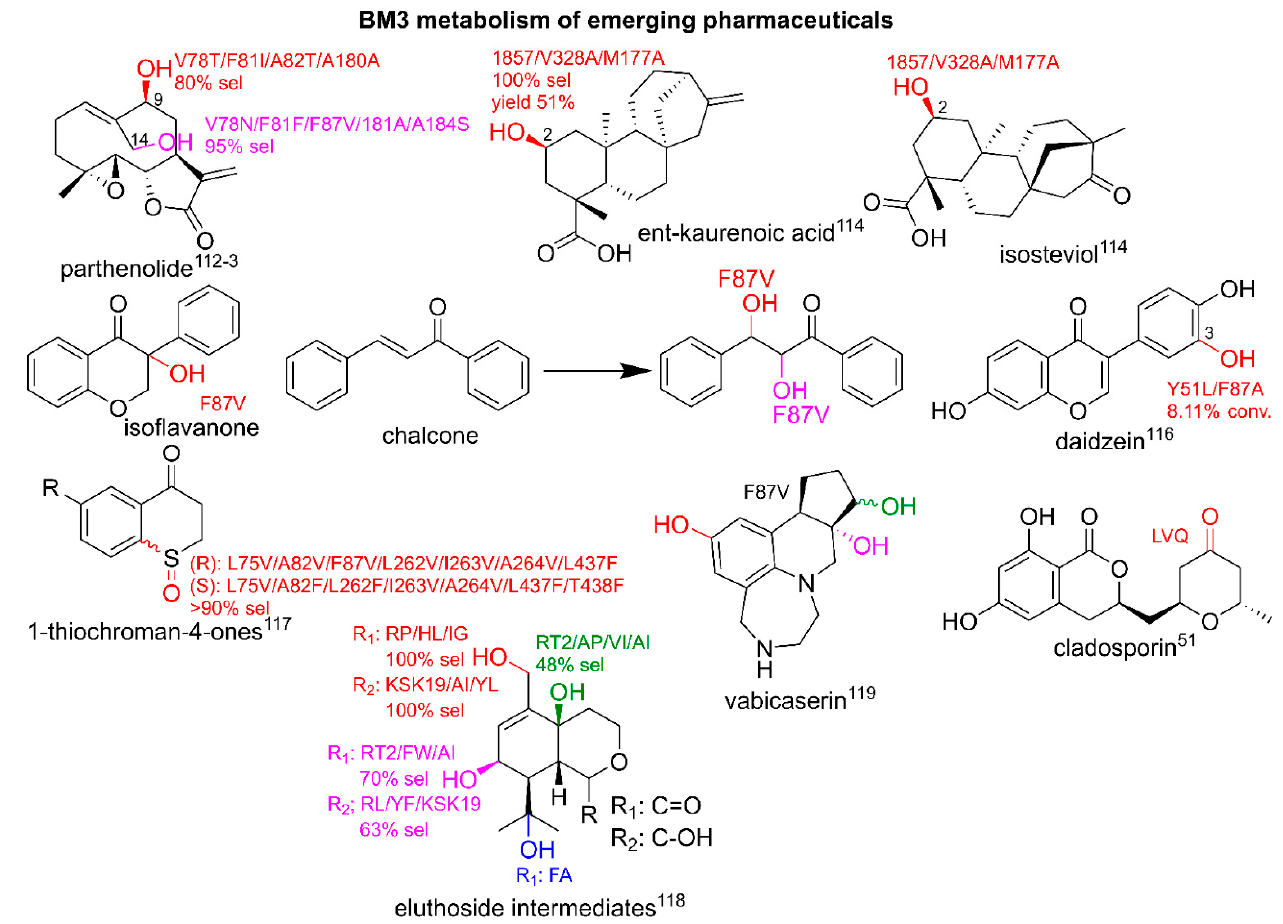
Figure 7. BM3-mediated metabolism of emerging pharmaceuticals. Parent compounds are in black. Modifications are in red, pink, green and blue. Conv, conversion; sel, selectivity. Literature references are in superscript.